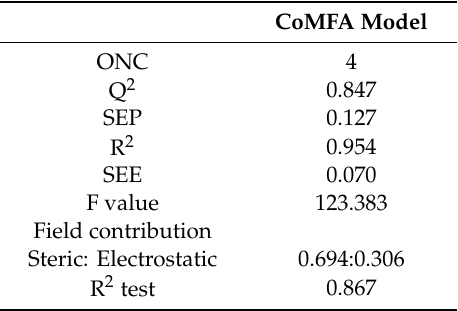
Table 2. Statistical parameters of the comparative molecular field analysis (CoMFA)